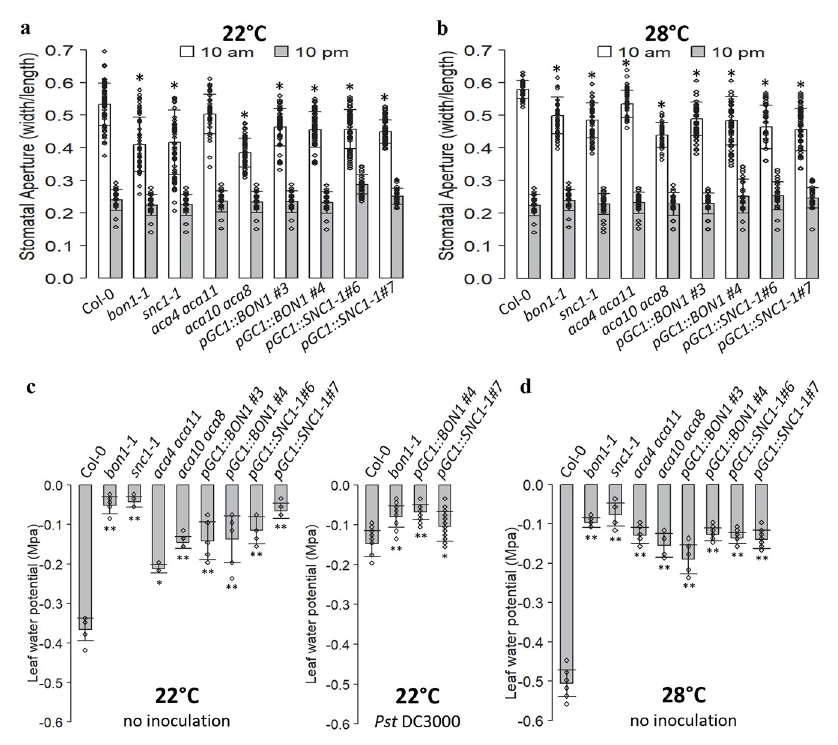
Fig 8. Stomatal aperture and water potential in Col-0, bon1-1 , snc1-1 , aca4 aca11 , aca10 aca8 , pGC1 :: BON1/bon1 and pGC1 :: snc1-1 chimeras. ( a , b ) Stomatal apertures measured at 10 am and 10 pm in in wild type, bon1-1 , snc1-1 , aca4 aca11 , aca10 aca8 , pGC1 :: BON1/bon1 and pGC1 :: SNC1-1 plants at 22˚C ( a ) and 28˚C ( b ). Biological duplicates were averaged, error bars indicate SDs (n = 60 stomata). Asterisks indicate statistically significant differences in stomatal aperture between Col-0 and the mutants at 10 am ( p < 0.001; based on one-way ANOVA followed by Duncan’s new multiple range test). ( c ) Leaf water potential measured in the indicated plant lines at 22˚C before and after 4 hours Pst DC3000 spray (OD600 = 0.05). ( d ) Leaf water potential in indicated plant lines at 28˚C. For c and d , plants were grown for 4 weeks and watered well the day before measurements. Asterisks indicate